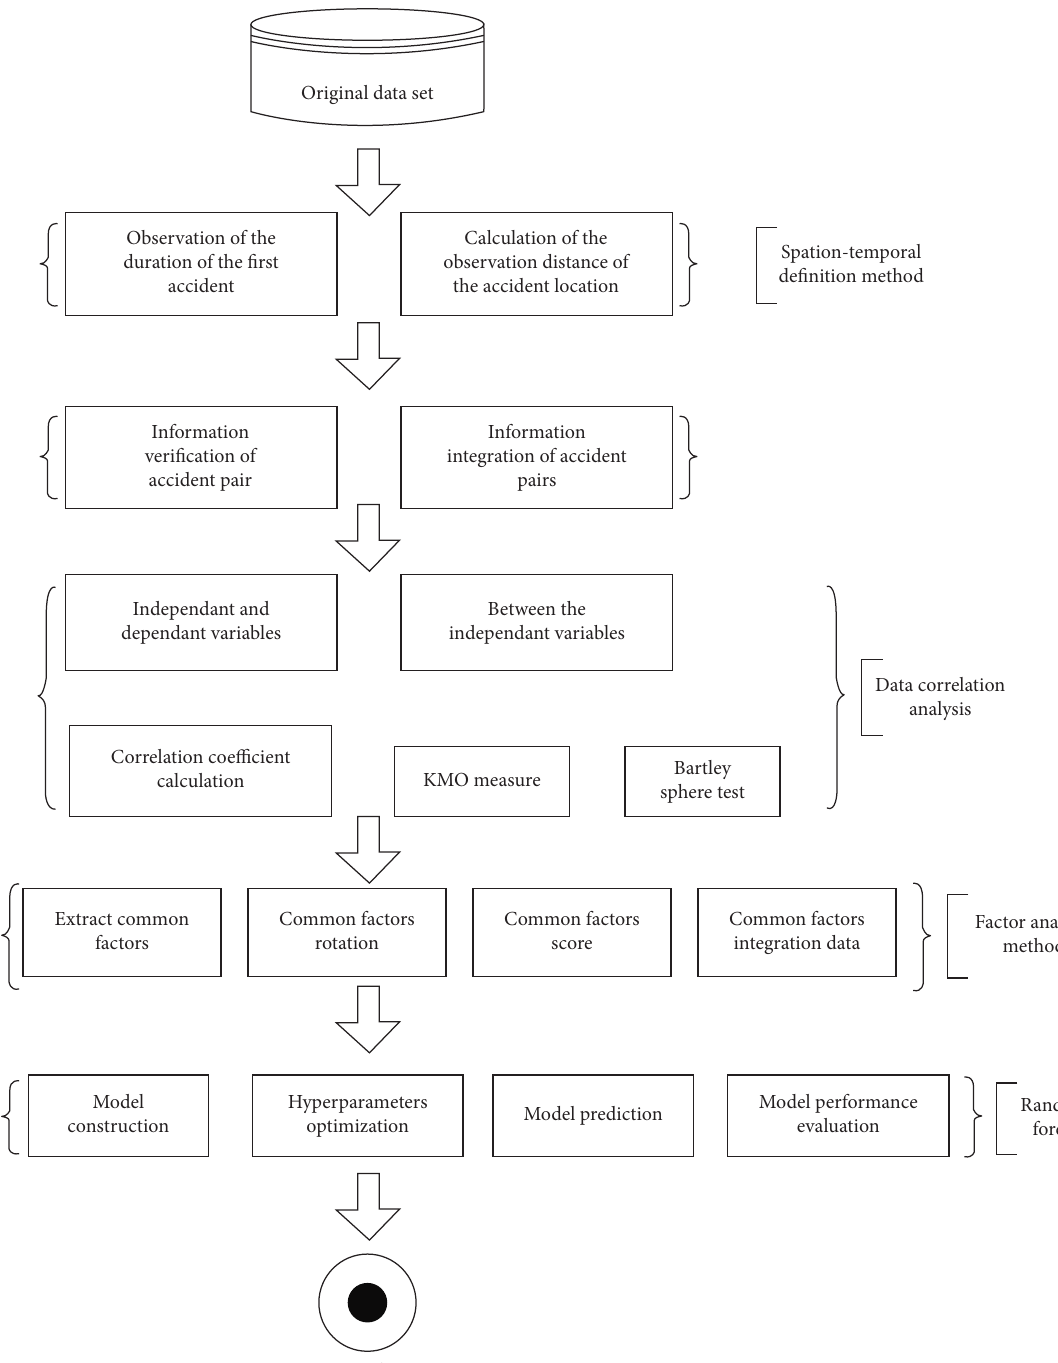
Figure 3: Interval duration prediction